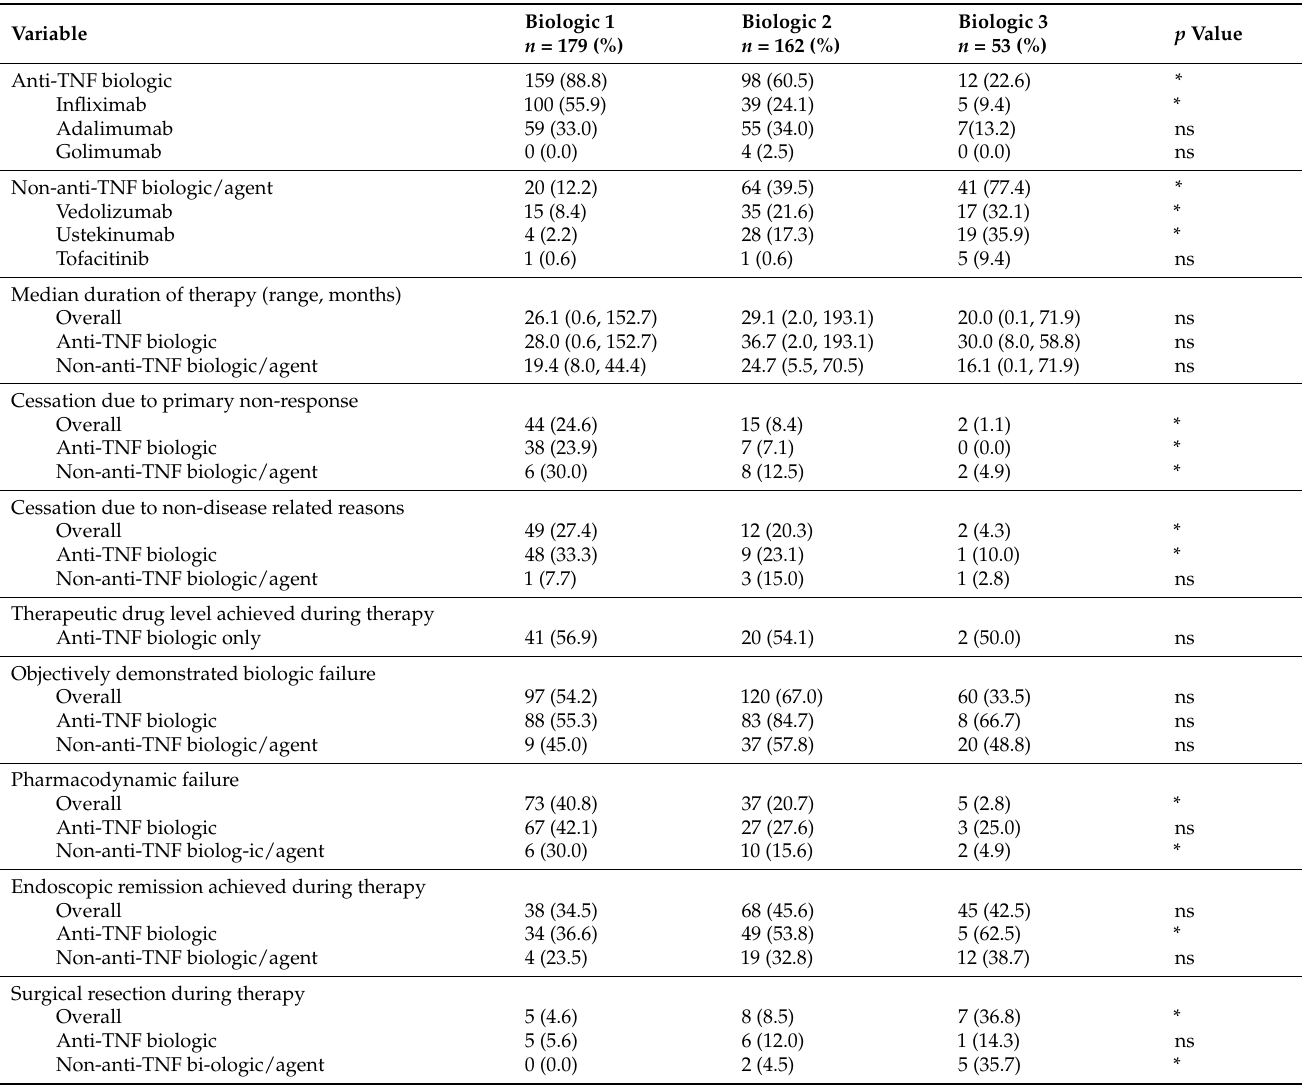
Table 2. Comparison of characteristics per successive biologic period (1st, 2nd,